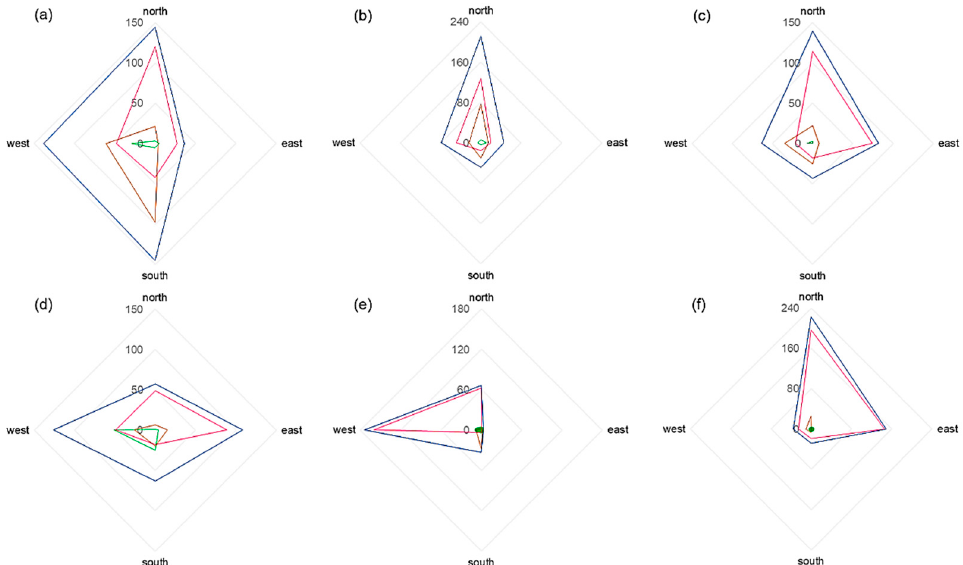
Figure A8. Pollen impaction (pollen grains/cm 2 ) on the vertical slides in 2019 for the pollen seasons: pre-pollen season: 18.03–09.04 (green), main pollen season: 09.04–23.04 (pink), post-pollen season: 23.04–14.05 (brown) and total (blue). For pollen traps 1 ( a ), 2 ( b ), 3 ( c ), 4 ( d ), 5 ( e ) and 6 ( f ) at the location Emmendingen.